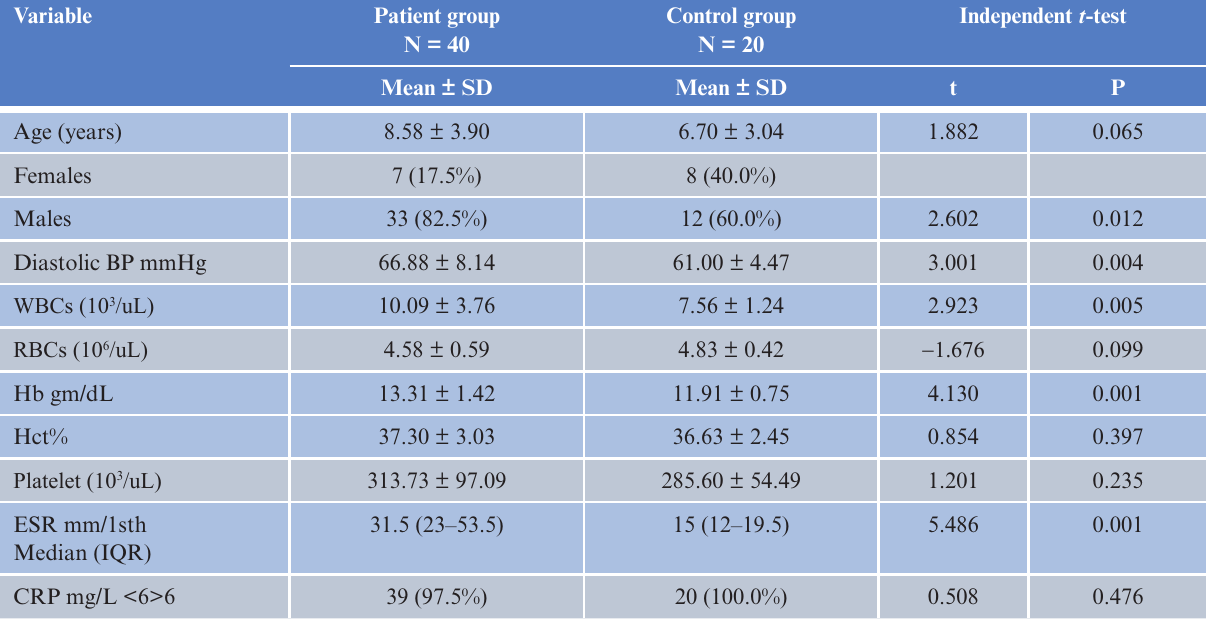
Table 1: Comparison between patient group and control group regarding demographic date, blood pressure, complete blood count, erythrocyte sedimentation rate, and C-reactive protein.